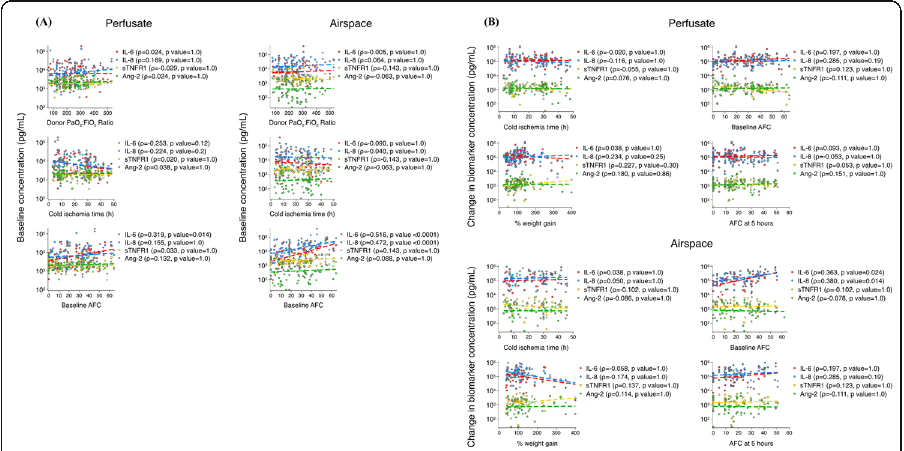
Fig. 2 Perfusate and airspace biomarkers at baseline and change after perfusion relative to lung characteristics. Associations between ( a ) baseline perfusate ( n =97) and airspace ( n =88) biomarker levels and donor lung characteristics, and ( b ) change in perfusate ( n =95) and airspace ( n =65) biomarker concentrations after 4h of ex vivo lung perfusion and donor lung characteristics and indicators of lung epithelial and endothelial injuries at the end of the experiment. p values are presented after a Bonferroni correction for multiple